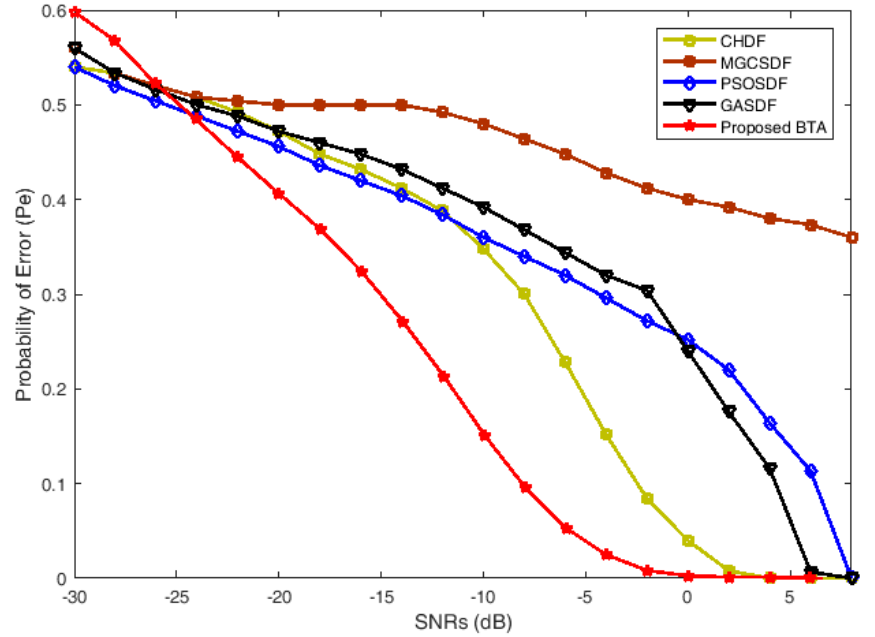
Figure 13. Probability of error vs. SNRs with opposite MUs.